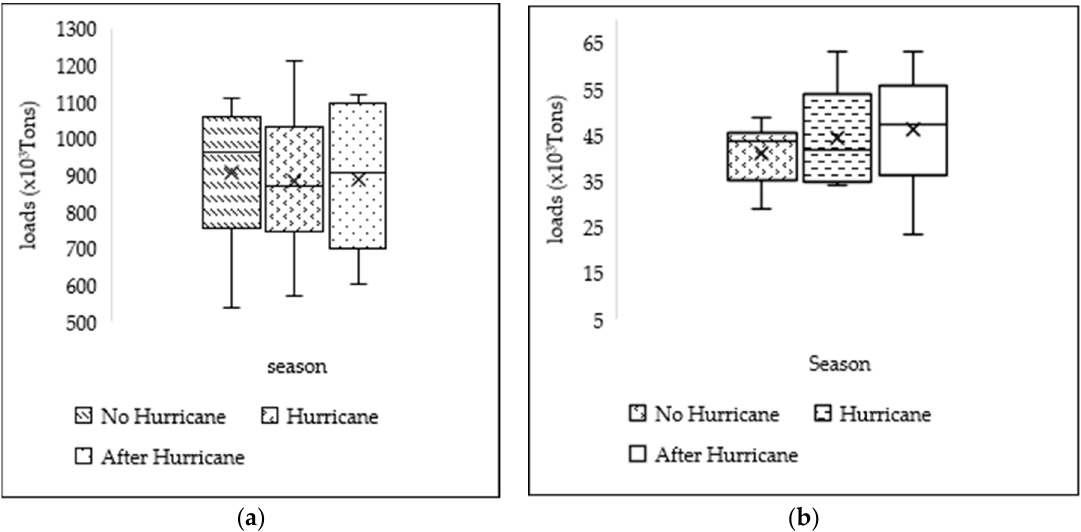
Figure 5. Comparison of variations in ( a ) NO 2 − + NO 3 − load and ( b ) orthophosphate load under normal weather, during hurricane, and after hurricane conditions.